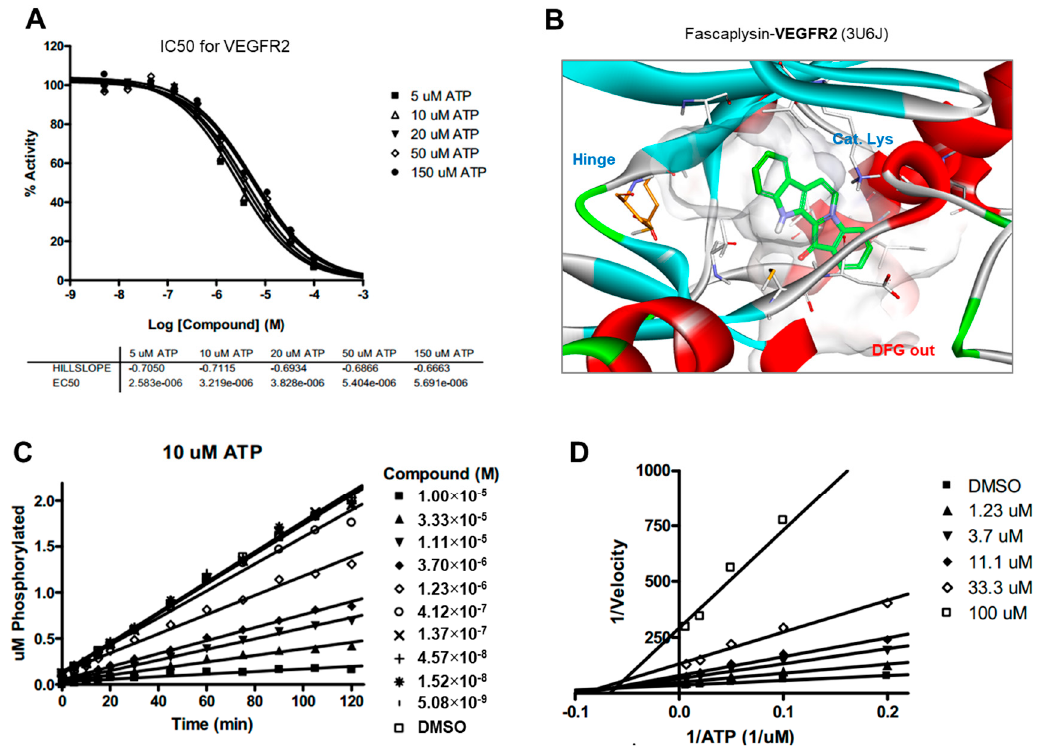
Figure 6. ATP competition studies over VEGFR2. The inhibition of VEGFR2 by fascaplysin was not time-dependent and was noncompetitive with respect to ATP. ( A ) IC50 curves for VEGFR2 at different ATP concentrations; ( B ) Calculated binding modes of fascaplysin in VEGFR2; ( C ) Progress curves for VEGFR2/fascaplysin; ( D ) Lineweaver-Burk plot for VEGFR2/fascaplysin.